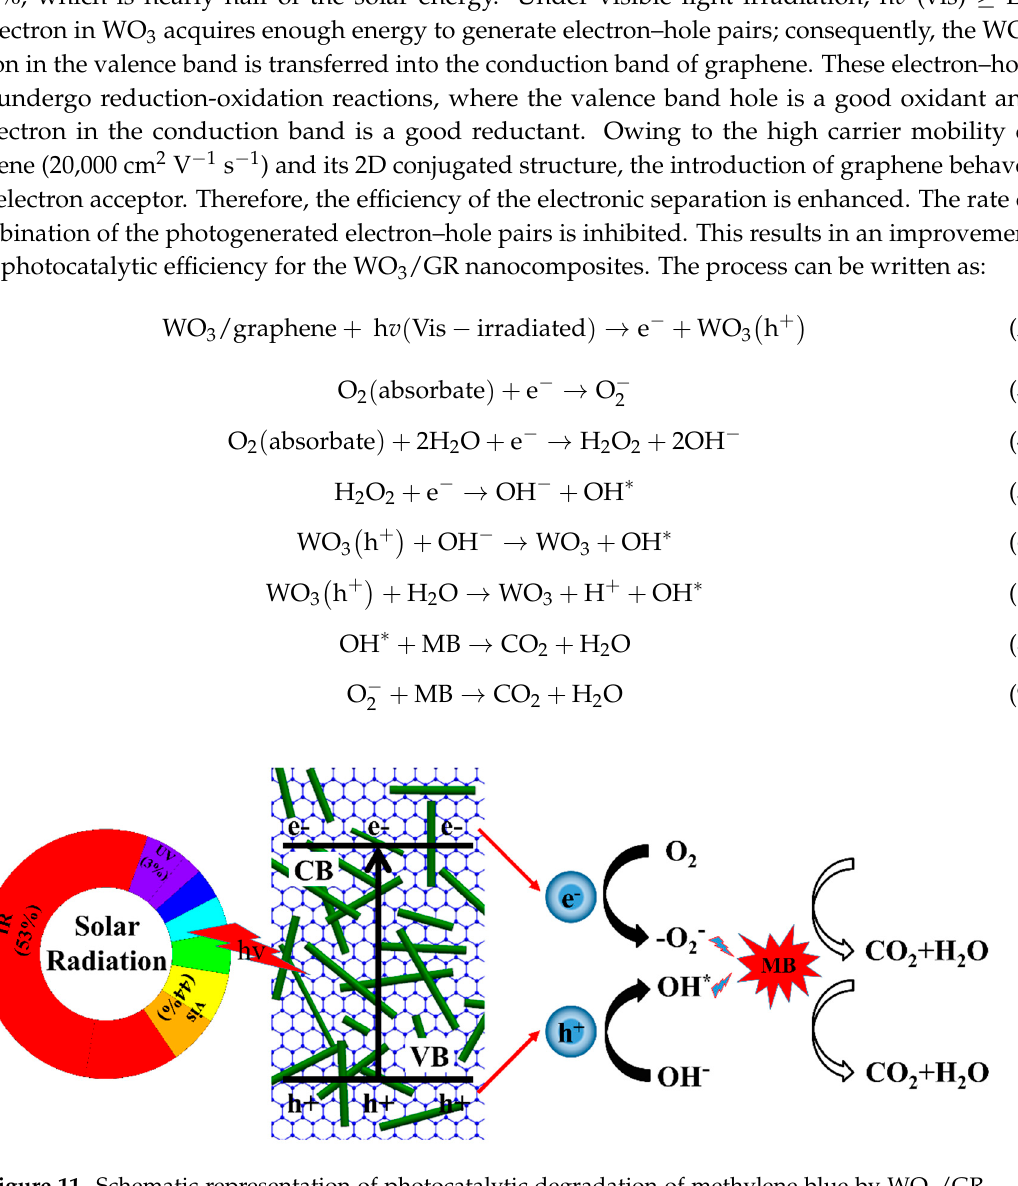
Figure 11. Schematic representation of photocatalytic degradation of methylene blue by WO 3 /GR nanocomposites under visible light illumination.